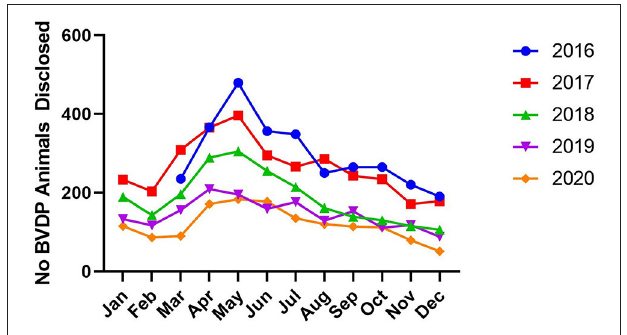
FIGURE 4 | The monthly incidence of BVDv positive cattle (BVDP) disclosure during the compulsory phase of the BVD eradication programme.